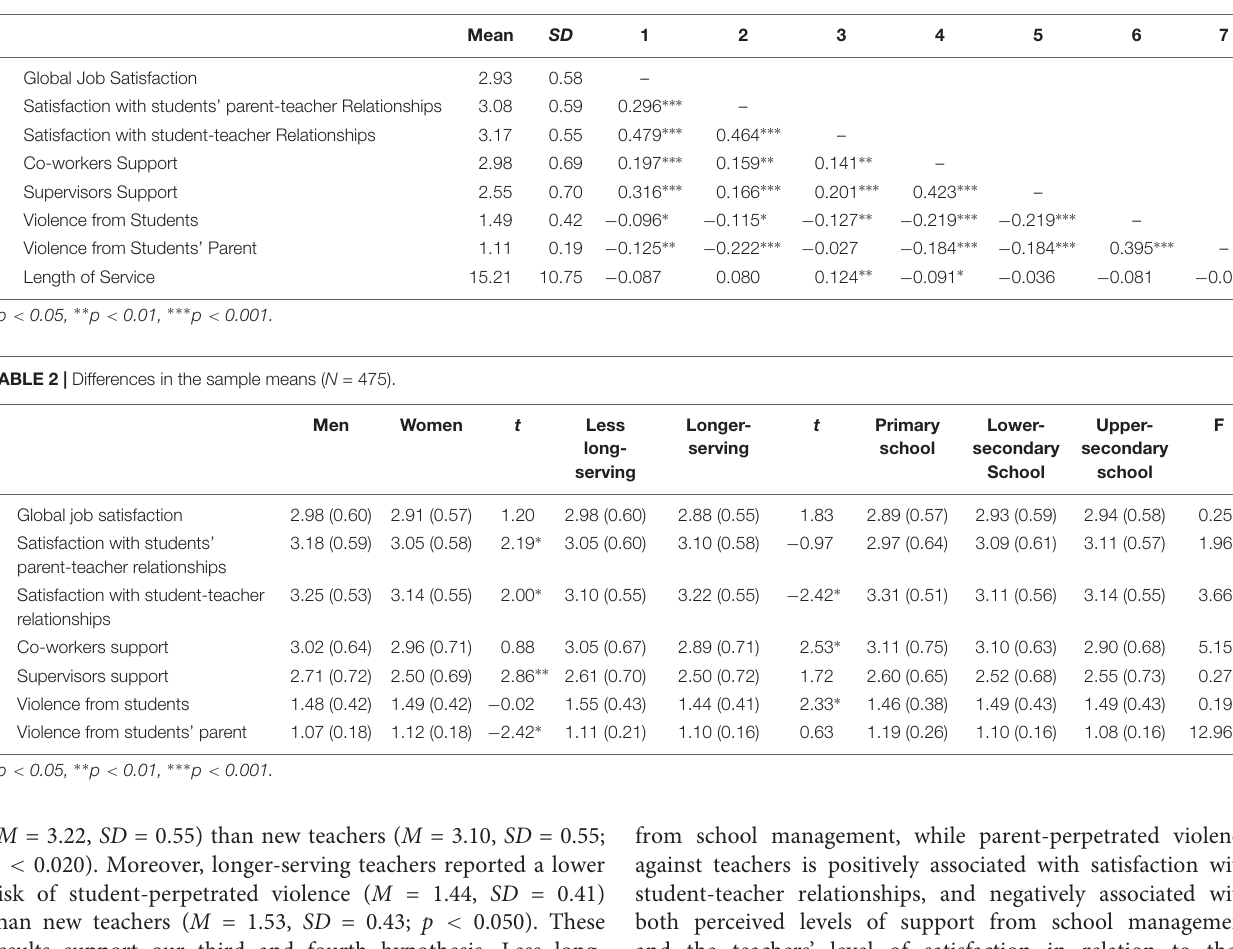
TABLE 1 | Descriptive Statistics and Intercorrelations ( N = 475).